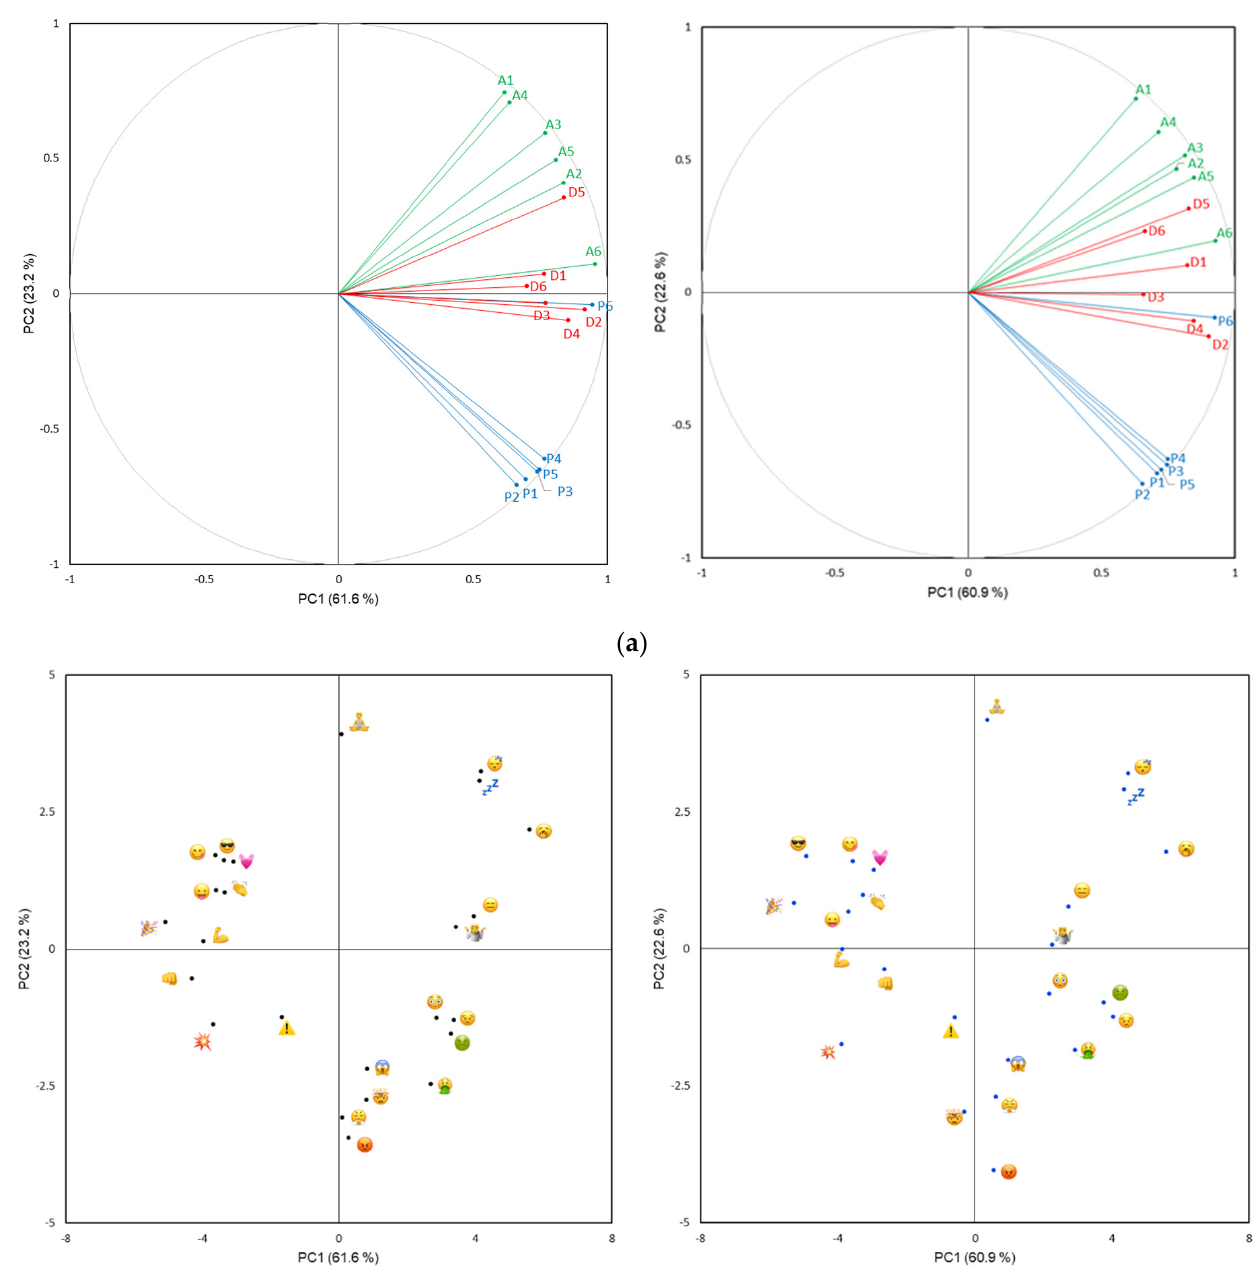
Figure 3. Two-dimensional spaces following Principal Components Analysis for PAD ratings of 24 emoji in Study 1 (NZ, left) and Study 2 (UK, right). ( a ) Variables plot spanned by PC1 and PC2, and ( b ) Observations plot spanned by PC1 and PC2. For variables plot, colors are used to visually highlight the PAD dimensions, with blue for P1 to P6, green for A1 to A6 and red for D1 to D6.